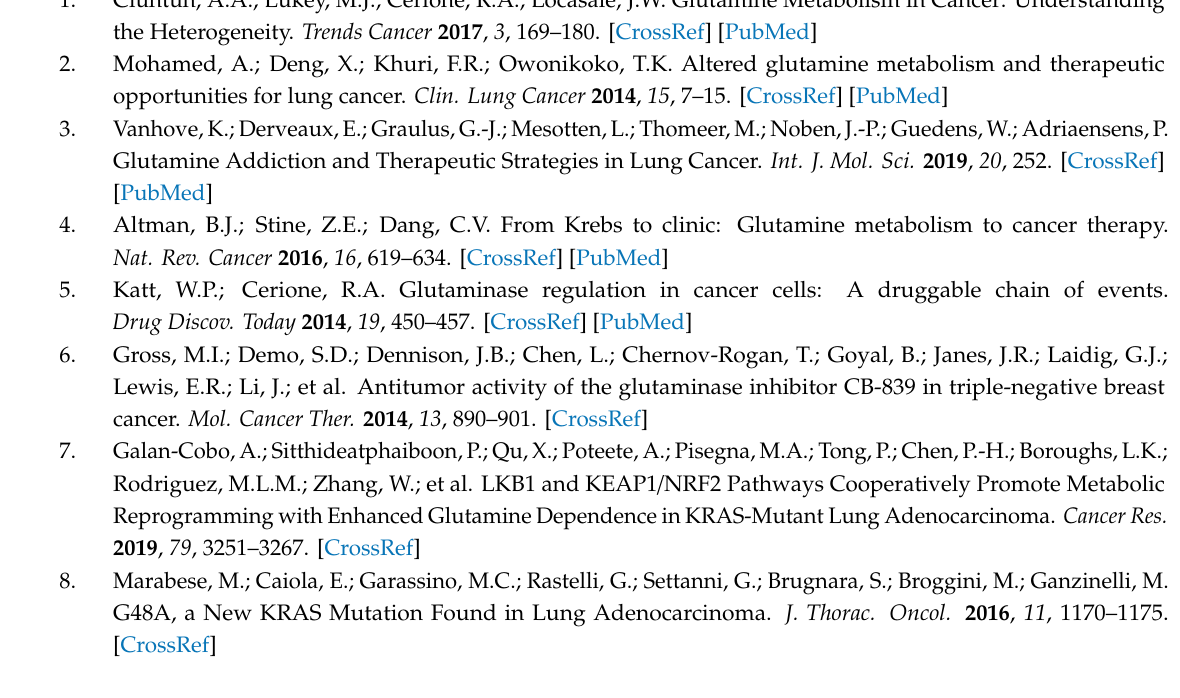
Figure S1: A. Dose–response curves of 6 NSCLC cell lines treated with increasing concentrations of CB-839 using SRB assay. B. DNA content, obtained by flow cytometric analysis, after 24 h or 48 h of treatment with CB-839 in sensitive and resistant cell lines; Figure S2: Dose–response curves of sensitive and resistant NSCLC H1299 isogenic cell clones treated with increasing concentrations of CB-839; Figure S3: Extracellular aspartate levels with or without CB-839 in two sensitive and two resistant H1299-derived clones; Figure S4: A. The 13C-labelled alanine incorporation in the resistant NSCLC H1299 isogenic cell clones treated with CB-839. B. The 13C-alanine-derived carbon labelling of TCA cycle intermediates and derived metabolites in CB-839 treated resistant H1299-derived clones; Figure S5: Dose–response curves of H1975 and H520 cells treated with increasing concentrations of l -cycloserine; Table S1: Significant di ff erences of the data presented in Figure 4B; Table S2: Significant di ff erences of the data presented in Figure 4D; Table S3: Significant di ff erences of the data presented in Figure 4E; Table S4: Significant di ff erences of the data presented in Figure